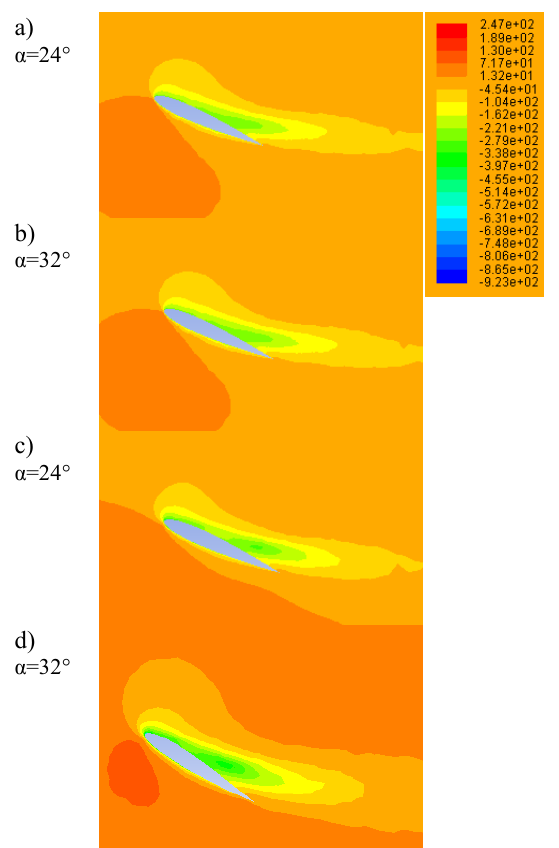
Fig. 5. The velocity contours over the wings in the middle plane at α =24 ° and α =32 ° with Transition SST model for rigid wing (a-b) and for tubercle wing (c-d) .